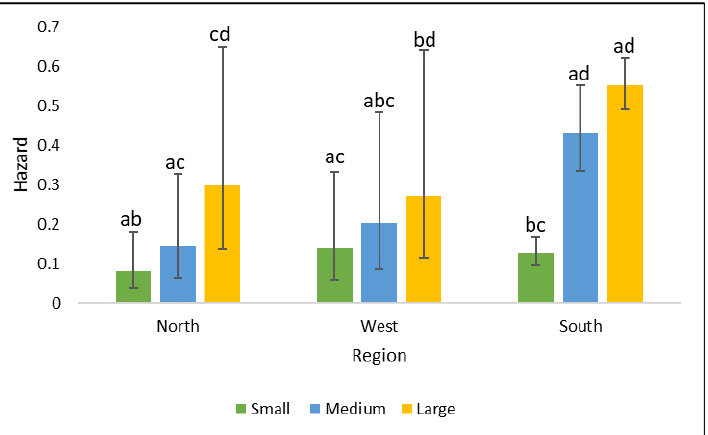
Figure 1. Euthanasia model adjusted region by size interaction displayed as hazards, estimated from the simple random sample of 4500 dogs. Error bars display one standard error from the estimated hazard ratios. Labels a–d indicate differences among hazards. Adjustment for multiple comparisons was performed using Tukey–Kramer methods. Table 2. Extended Cox regression model for euthanasia using the simple random sample of 6200 dogs. Adjustment for multiple comparisons was performed using Tukey–Kramer methods.